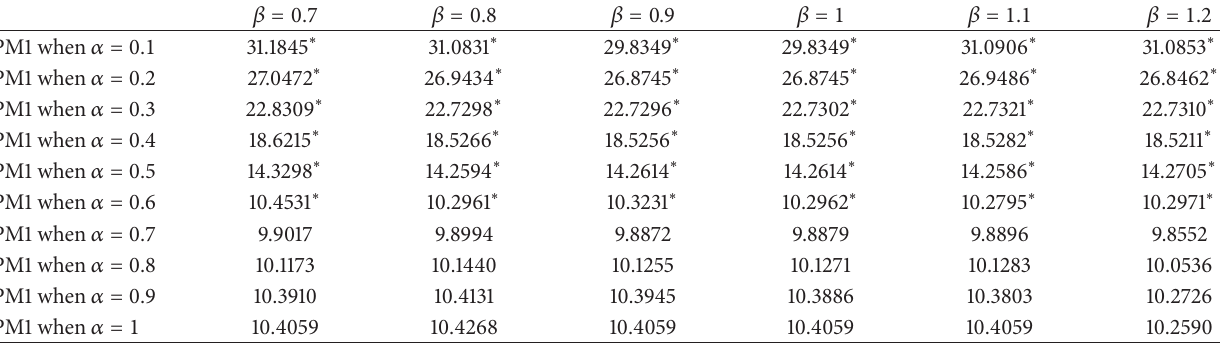
Table 1: Prediction errors of the new improved parsimonious multivariate Markov chain model with original convergence condition in Example 2.